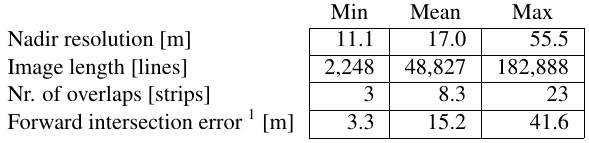
Table 1: Statistics of 98 HRSC image strips located in MC-11-E Also the distribution of the tie points, needed for the adjustment and found by an automated matching procedure (Schmidt et al., 2008) is heterogeneous (Figure 2b). This is caused by varying